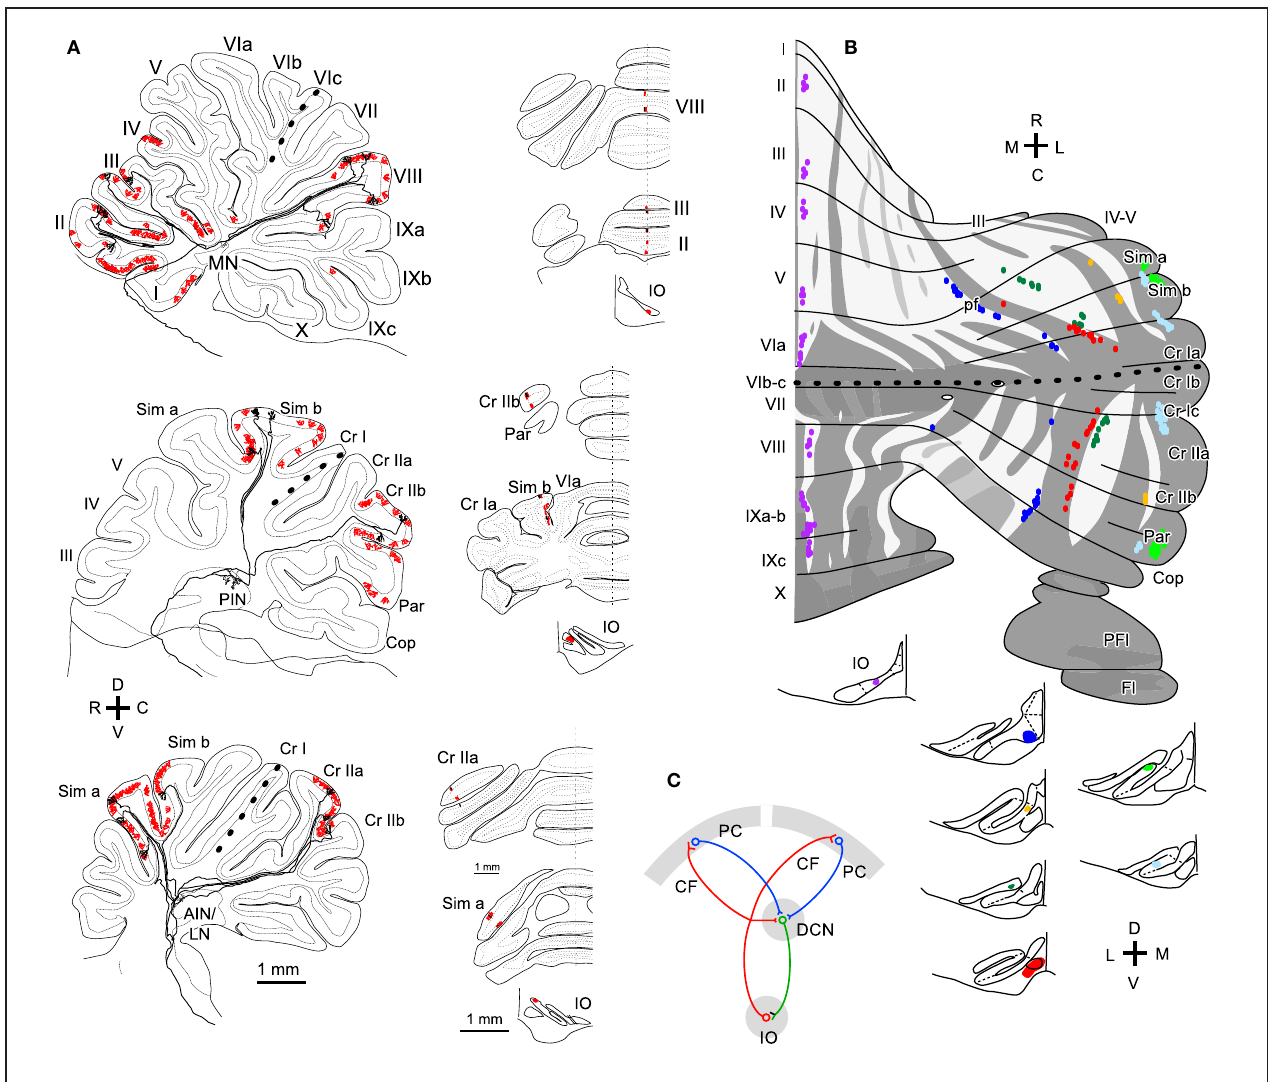
aldolase C compartments in the cerebellar cortex. Cases in which CFs were labeled only in longitudinally separate pair of equivalent compartments are summarized here, suggesting longitudinal branching. (A) and (B) are based on the data in experiments in Sugihara et al. (2001) and Sugihara and Quy (2007), respectively. (C) Schematic of the closed-loop-shaped modular organization between the IO, cerebellar cortex and DCN modified by the longitudinal branching of the OC